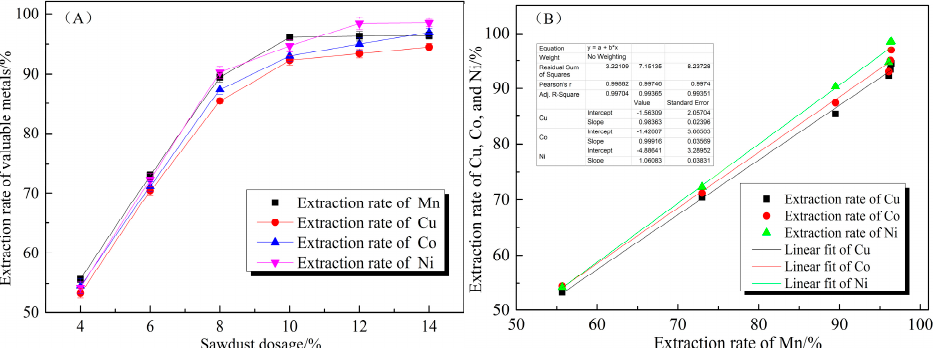
Figure 3. The effect of sawdust dosage on the extraction rates of Mn, Cu, Co, and Ni ( A ); linear relationships between Mn extraction rate and Cu, Co, and Ni extraction rates ( B ).